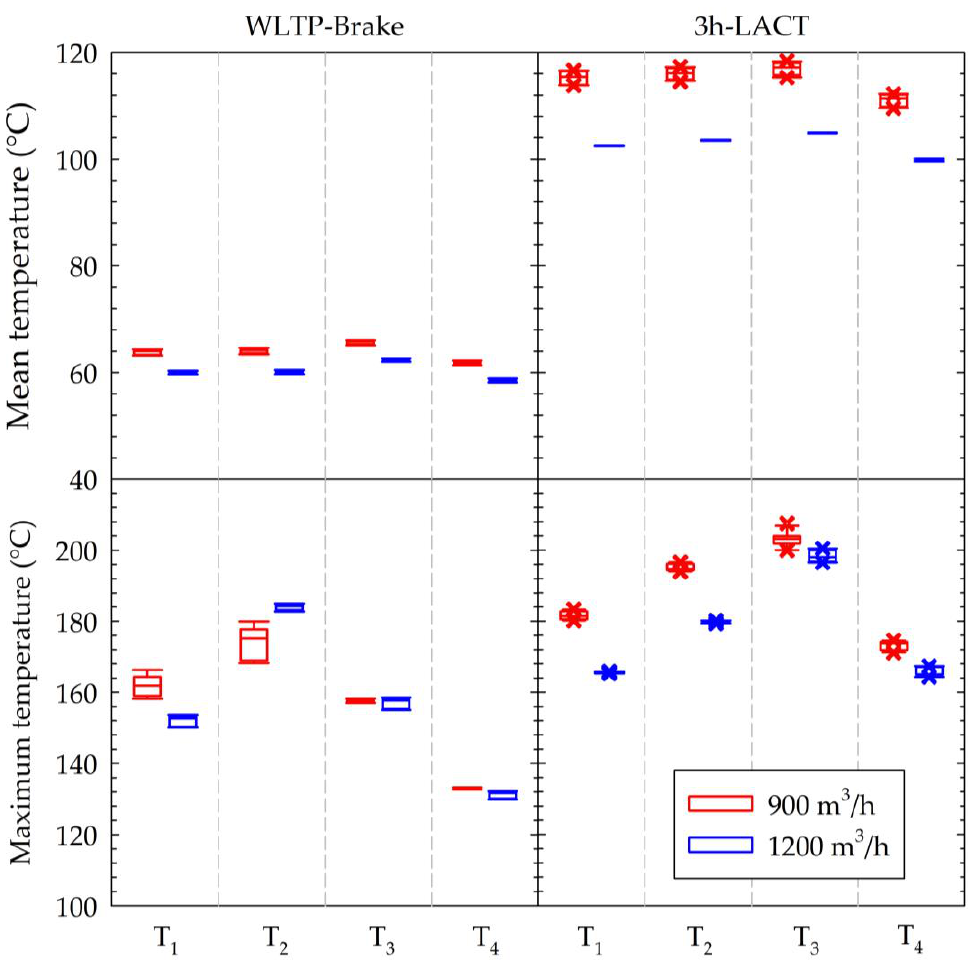
Figure 3. Cycle-average ( top panels ) and peak ( bottom panels ) disc temperatures over the WLTP-Brake ( left-hand panels ) and 3h Los Angeles City Traffic cycle (3h-LACT) ( right-hand panels ) cycle at a tunnel flow of 900 m 3 /h (red boxplots) and 1200 m 3 /h (blue boxplots) measured with the 4 thermocouples (T1 to T4). Boxplots indicate the median, 25th and 75th percentiles, error bars correspond to the 10th and 90th percentiles, and crosses refer to the 5th and 95th percentiles.